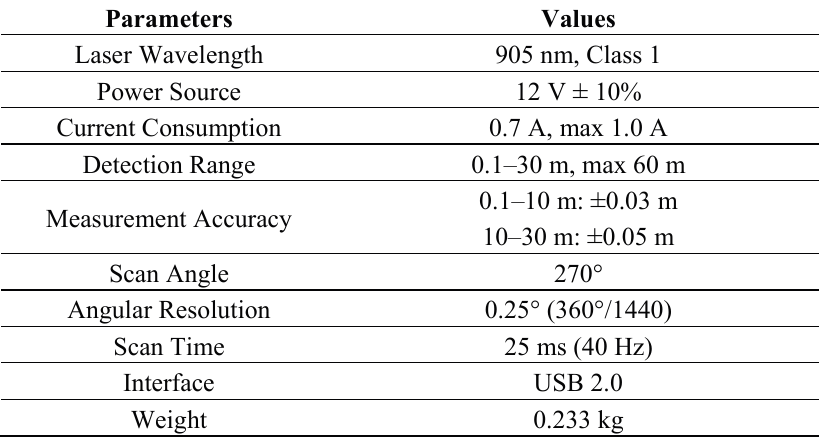
Figure 4. Appearance of the UTM-30LX. Table 1. Specifications of the